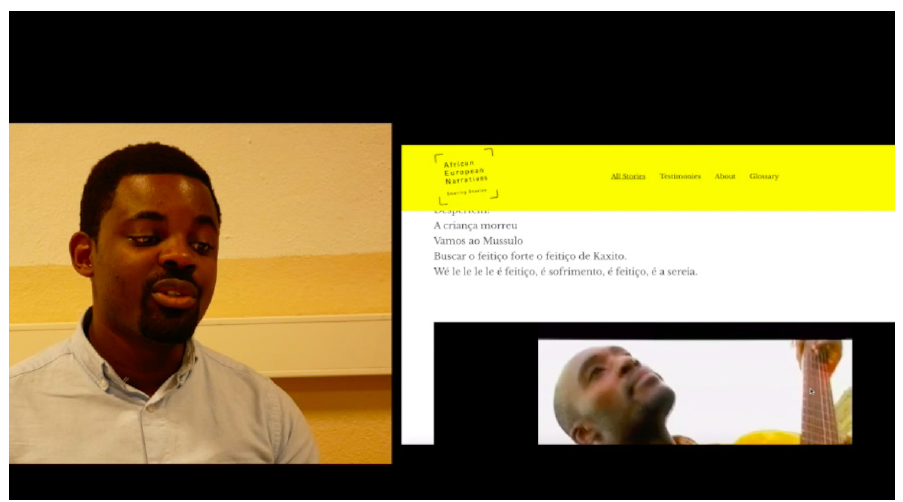
Figure 1. Film still from “From Here and There.” Source: Miranda